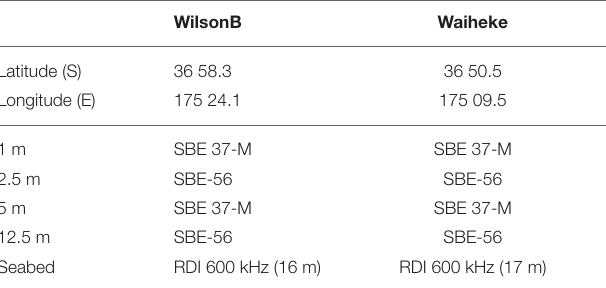
TABLE 2 | Summary of mooring observations collected at WilsonB and Waiheke from June 2012 to July 2013. Seabird microcats (SBE-37M) sampled salinity, temperature and pressure every 60 s, continuously. Temperature was sampled at 1 Hz using a Seabird 56 thermistor (SBE56). The RDI ADCPs burst-sampled, with 1-min averages recorded every 10 min in 0.5 m